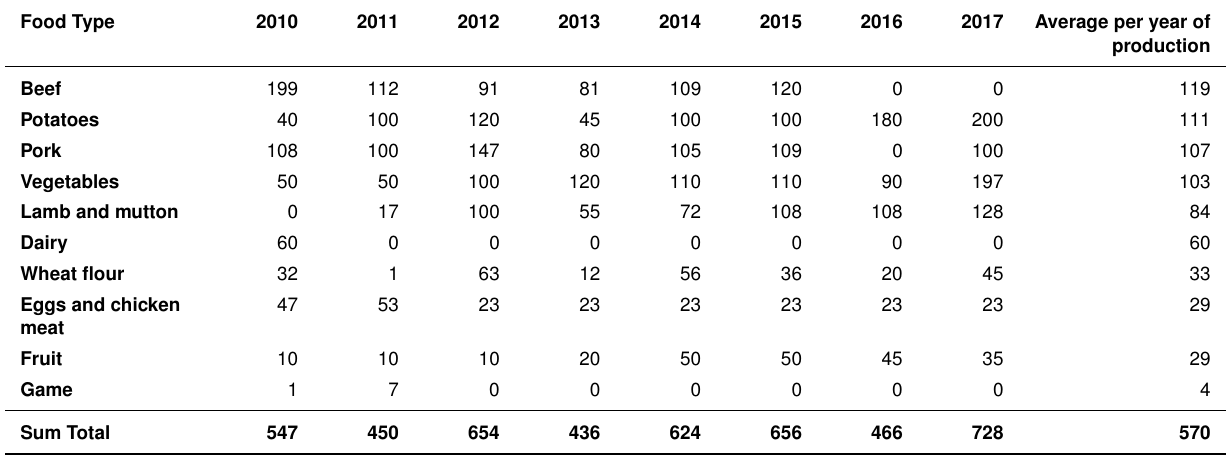
Table 6. Weight of food produced (kg),